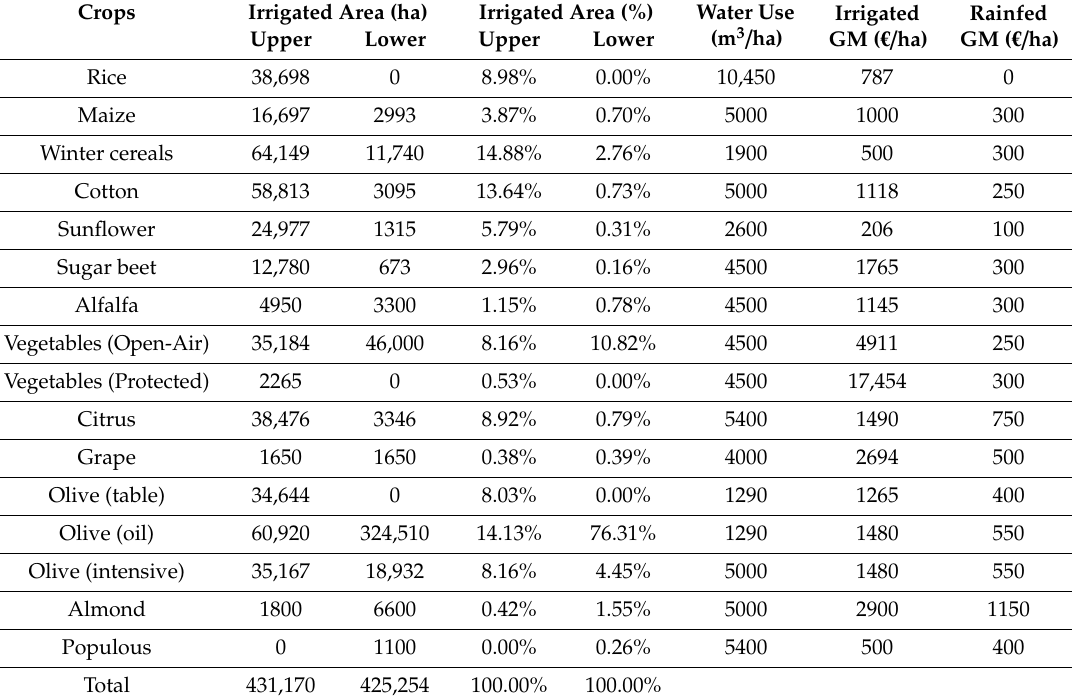
Table 2. Characterisation of the irrigated agriculture sector in the basin. Guadalquivir 2012.